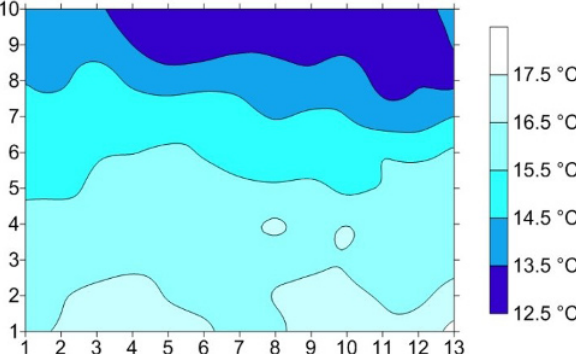
Fig. 14. The cut of the modified thermogram of the cold air stream measuring between the front passenger and driver area by measuring from the tripod stand From horizontal, the airflow was set to 25° and the measurement was carried out in the cooling mode. The